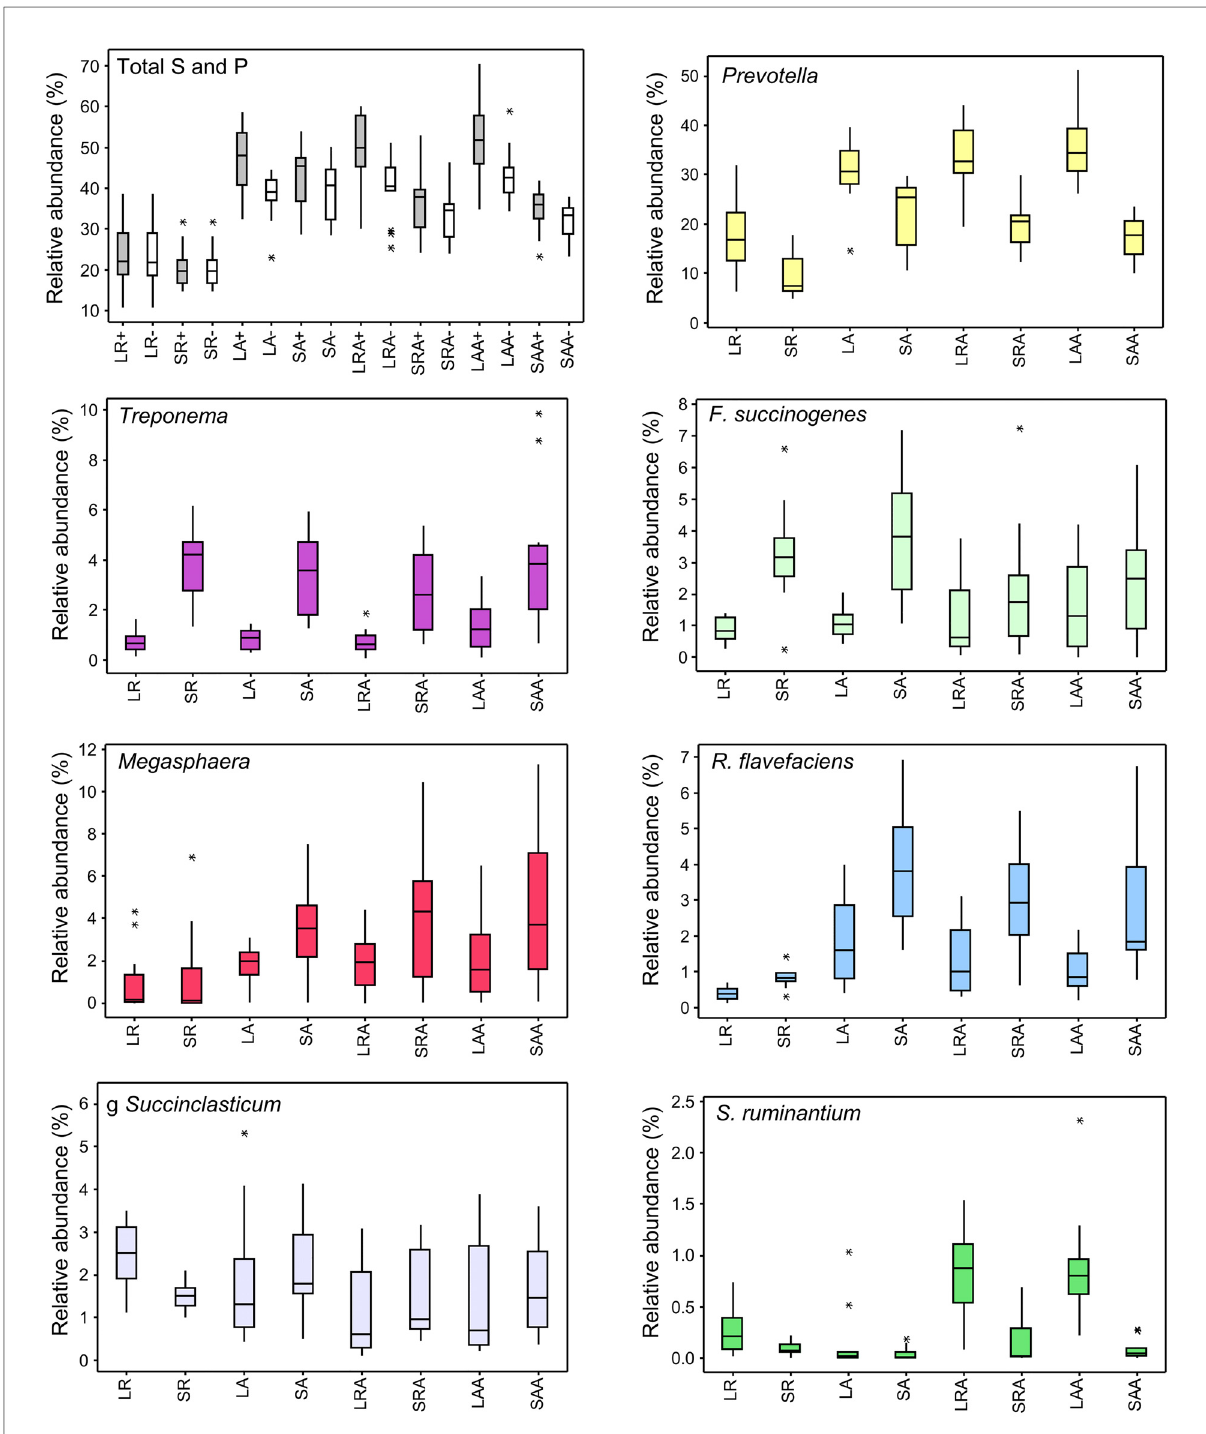
Fig 8. Differences in relative abundance of succinate and propionate producers between treatment groups. Box and whisker plots showing median, quartiles, maximum and minimum values, and outliers (asterisks) for the sum of relative abundances within each rumen sample of OTUs assigned to taxonomic groups (apart from Succinivibrionaceae) which are, or have members which are, succinate and propionate (S and P) producers. ‘ Total S and P ’ box and whisker plot shows sum of relative abundances of all OTUs assigned to S and P taxonomic groups excluding OTU-S3004 (white boxes-) and including OTU-S3004 (grey boxes +). LR = Liquid Restricted (n = 14), SR = Solid Restricted (n = 14), LA = Liquid Ad lib (n = 13), SA = Solid Ad lib (n = 13), LRA = Liquid Restricted/ Ad lib (n = 15), SRA = Solid Restricted/ Ad lib (n = 15), LAA = Liquid Ad lib / Ad lib (n = 13), SAA = Solid Ad lib / Ad lib (n =